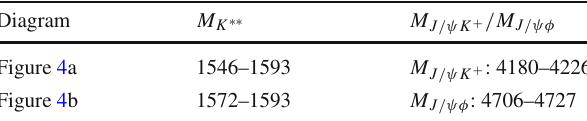
Table 2 TS kinematic region corresponding to the rescattering dia- grams in Fig. 4, in unit of MeV